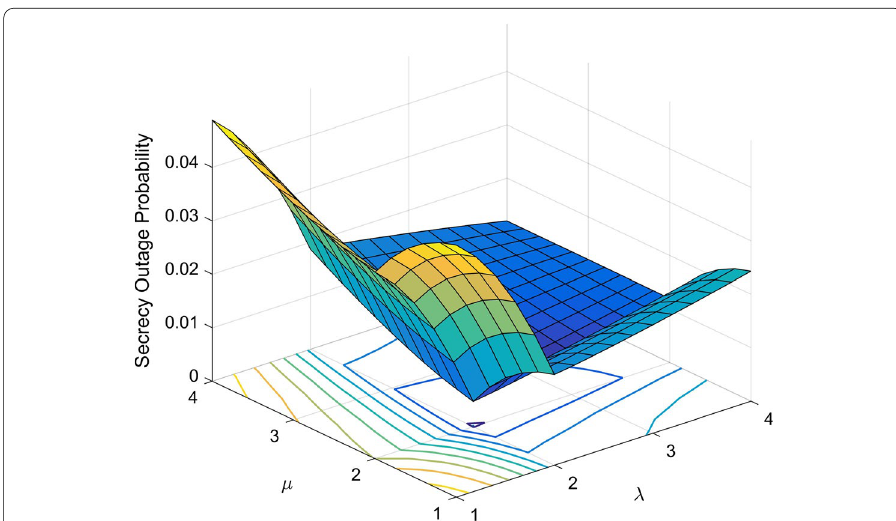
Fig. 6 The secrecy outage probability versus (cid:31) and µ for the proposed